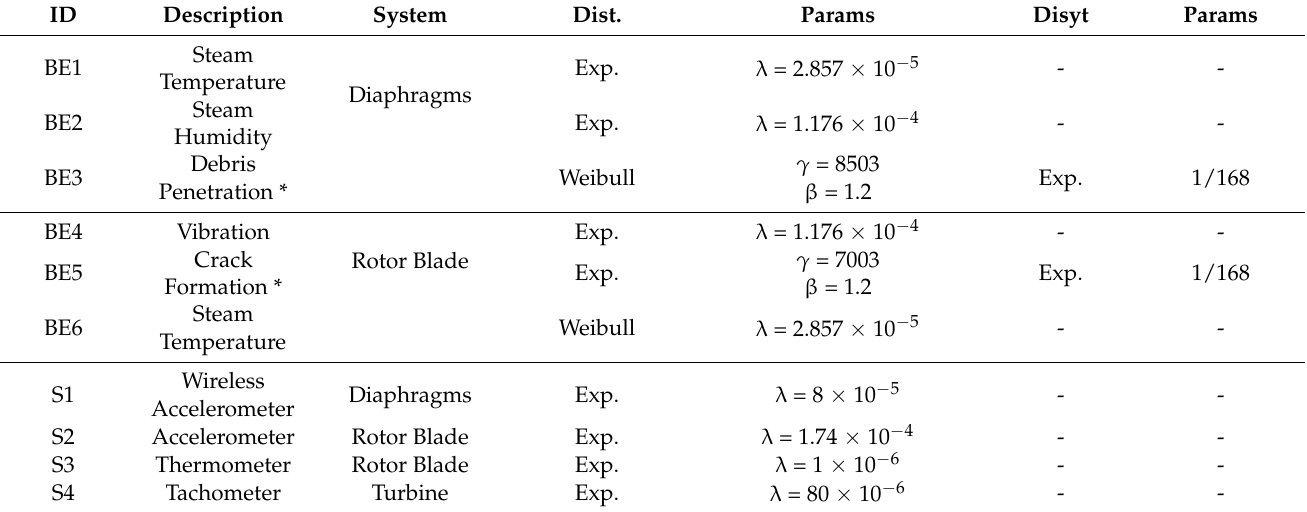
Table 8. Parameters of the Dynamic Fault Tree Basic